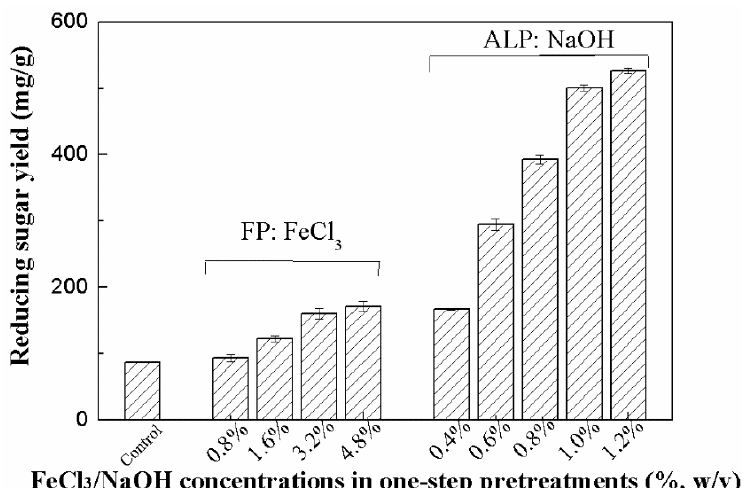
Figure 1. Enzymatic hydrolysis of the stalk samples.